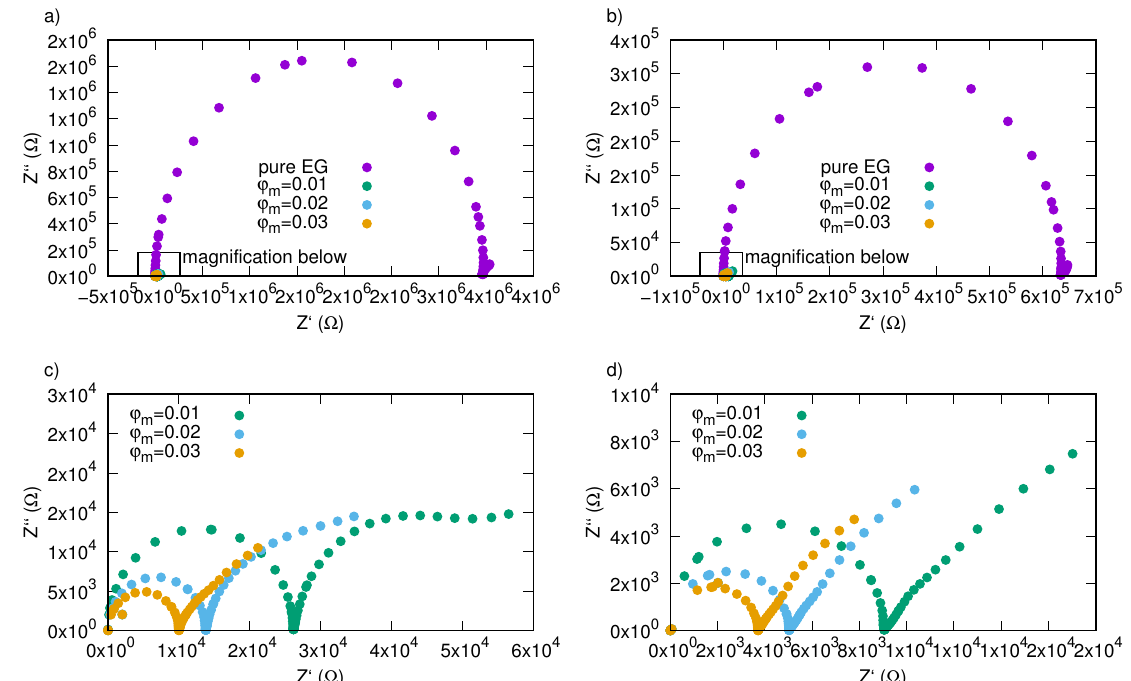
Figure 10. Nyquist plots of silicon oxide lignin ethylene glycol nanofluids as function of frequency for temperature ( a ) 298.15 K, ( b ) 333.15 K; ( c ) magnification of selected area from subfigure “a” for 298.15 K, ( d ) magnification of selected area from subfigure “b” for 333.15 K.